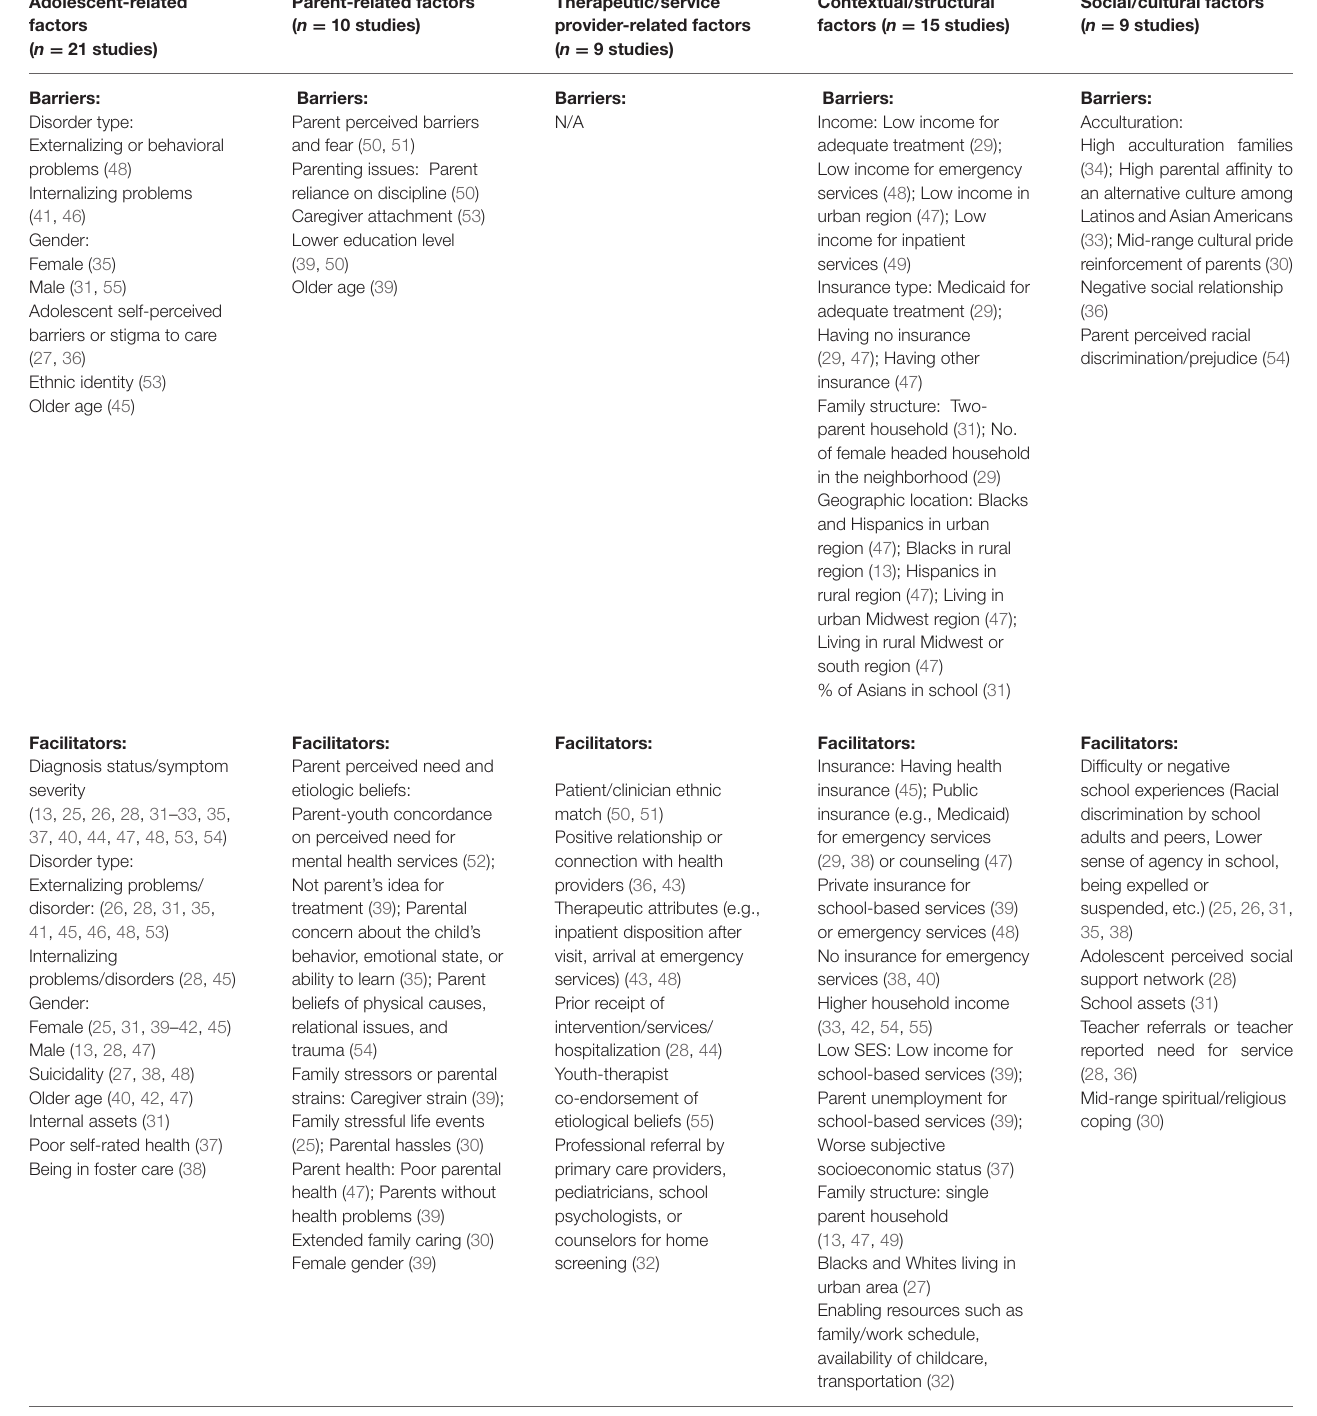
TABLE 3 | Categorization of barriers and facilitators* for mental health service use among racial/ethnic minority youth by the Social Ecological Model ( N = 32 studies). Adolescent-related